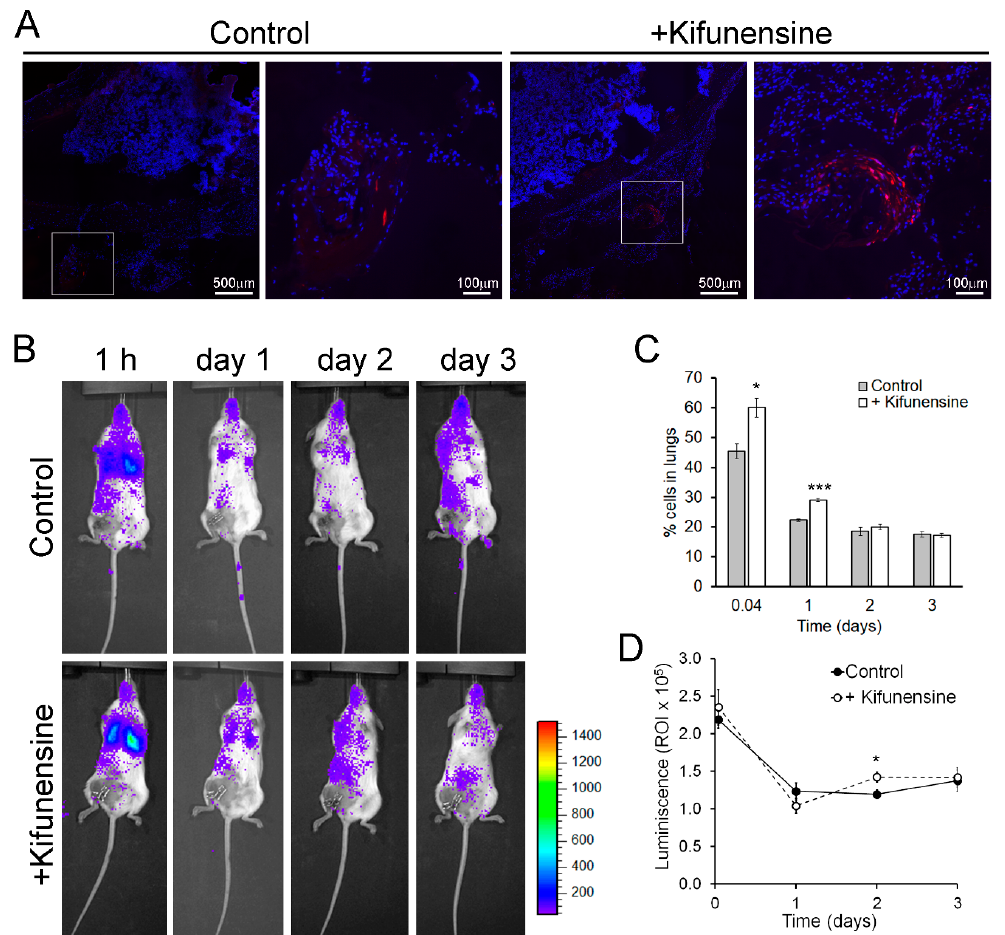
Figure 2. Pre-treatment with Kifunensine promotes the migration of MSCs in vivo. ( A ) Bone fracture model in NSG mice showing the distribution of tdTomato-positive MSCs (red) in the proximity of the fractured femur. High magnification images correspond to squares in low magnification images. Nuclei are stained with DAPI (blue). Cells (treated with or without Kifunensine) were injected percutaneously the same day of fracture and analyzed three days after ( n = 4 mice per condition). ( B ) Mice with hind limb ischemia, where MSCs expressing luciferase were injected via the tail vein and imaged 1 h after or 1, 2 and 3 days after surgery. ( C ) Quantification of cells in the lungs ( n = 5 mice per condition). ( D ) Total luminescence detected over time ( n = 5 mice per condition). * p < 0.05, *** p < 0.0005.